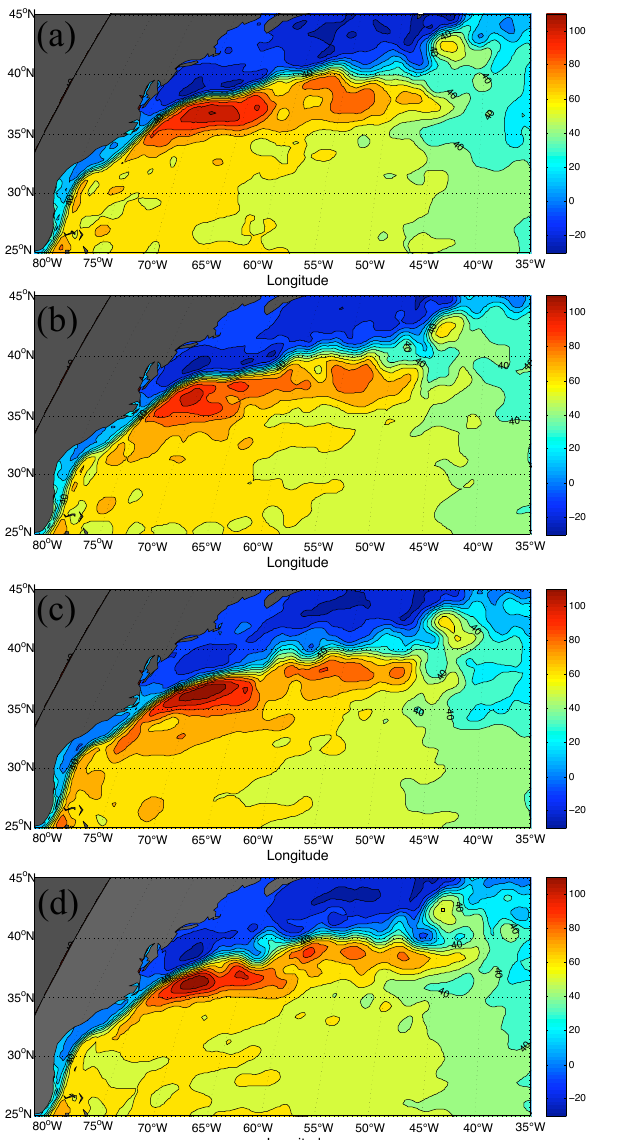
Fig. 8. Simulated snapshots of the SSH (cm) corresponding (from top to bottom) to the first field of t = 26, 15, 8,